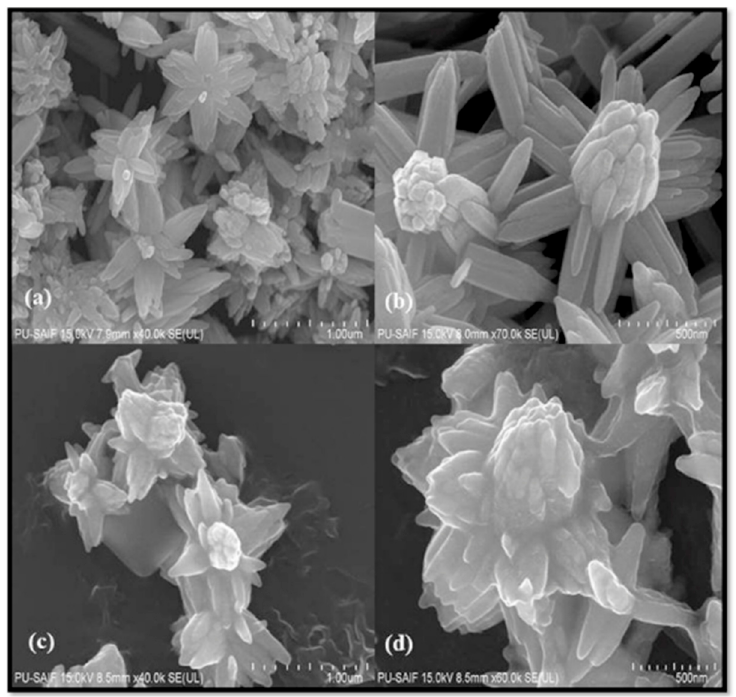
Figure 4. FESEM images of nitrogen doped ZnO ( a ) and ( b ) and of the N-ZnO/CQDs composites ( c ) and ( d ). Reprinted with permission from Ref. [97]. Copyrights 2017,